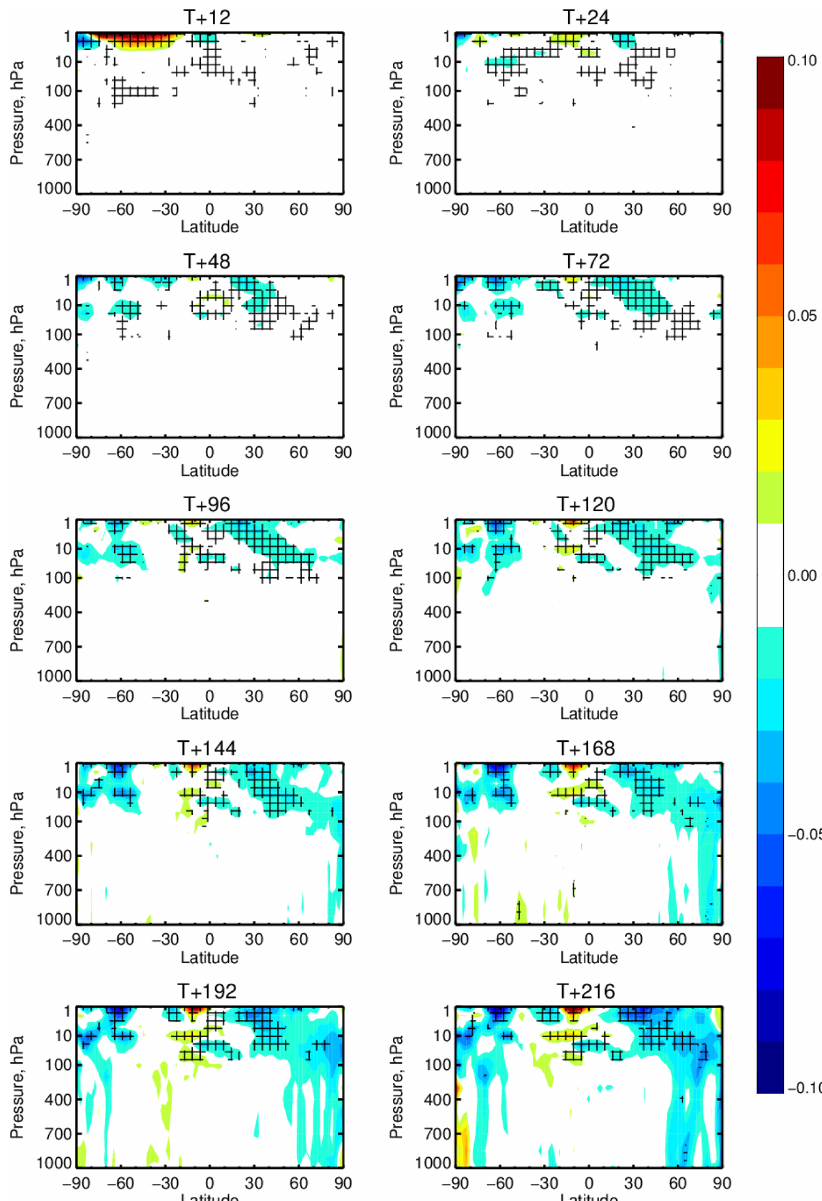
Figure 13. Cross sections for the change of RMSE in the vector wind velocity (ms − 1 ) for different lead times (24 to 240h) for the period 15 December 2015–15 February 2016. Each experiment, one using the new ozone scheme interactive with radiation and one using the default scheme, is compared to the ECMWF operational analysis as reference for normalising the error difference; this figure displays the differences between both experiments compared to the reference. Hatched regions indicate where results are statistically significant to the 95% confidence